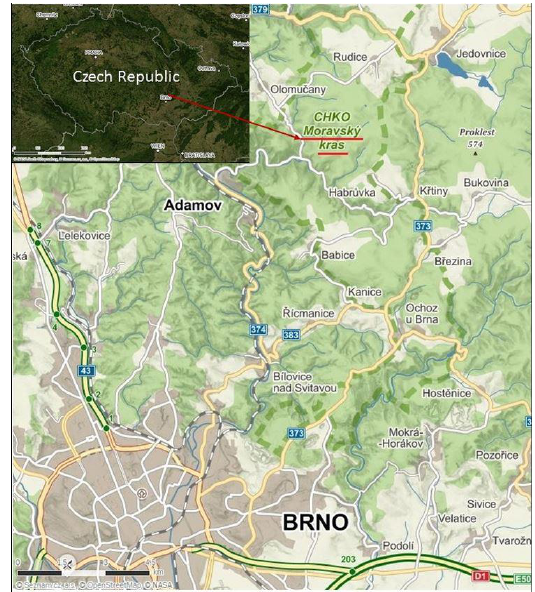
Figure 1. Study area (Czech - Moravský krás) © Image